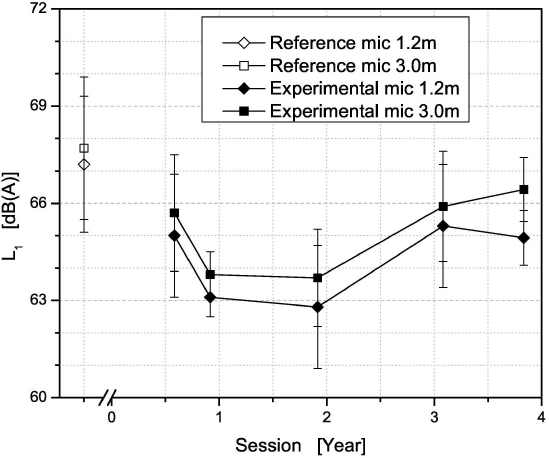
Figure 18. Time evolution of SPB values in Site 5. In white ante-operam values.